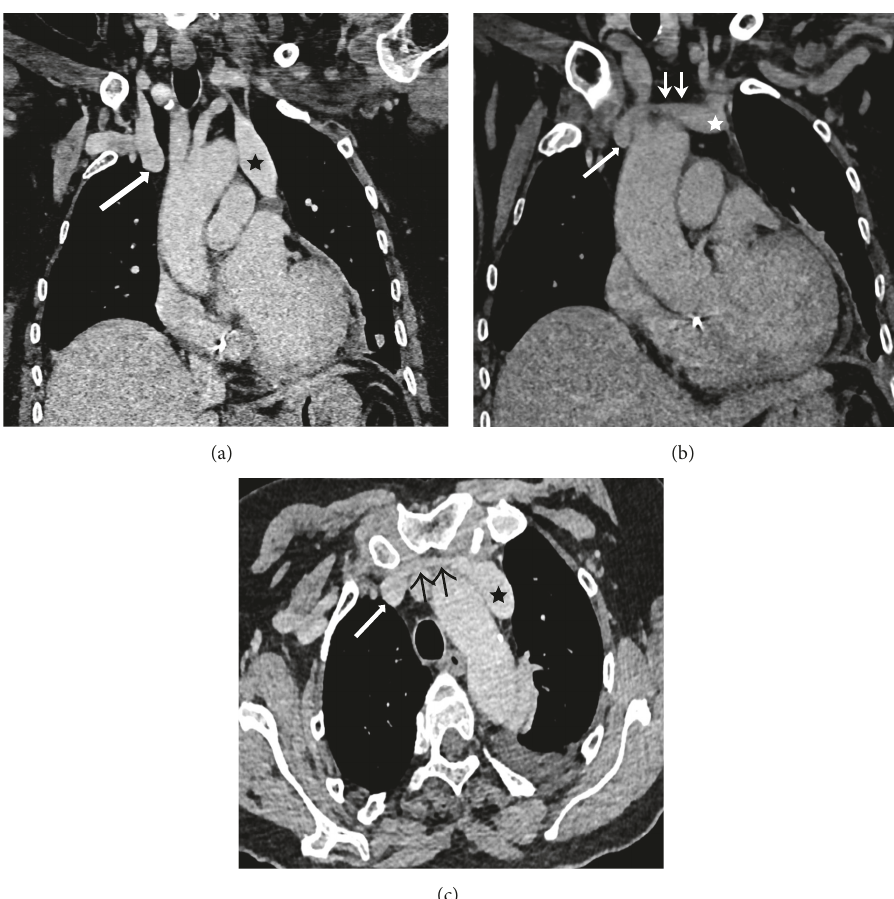
Figure 1: Computer tomography: two consecutive coronal reformatted (a and b) and axial images (c) show stump of the superior vena cava (long arrow), bridging vein (short arrows), and persistent left superior vena cava (star).